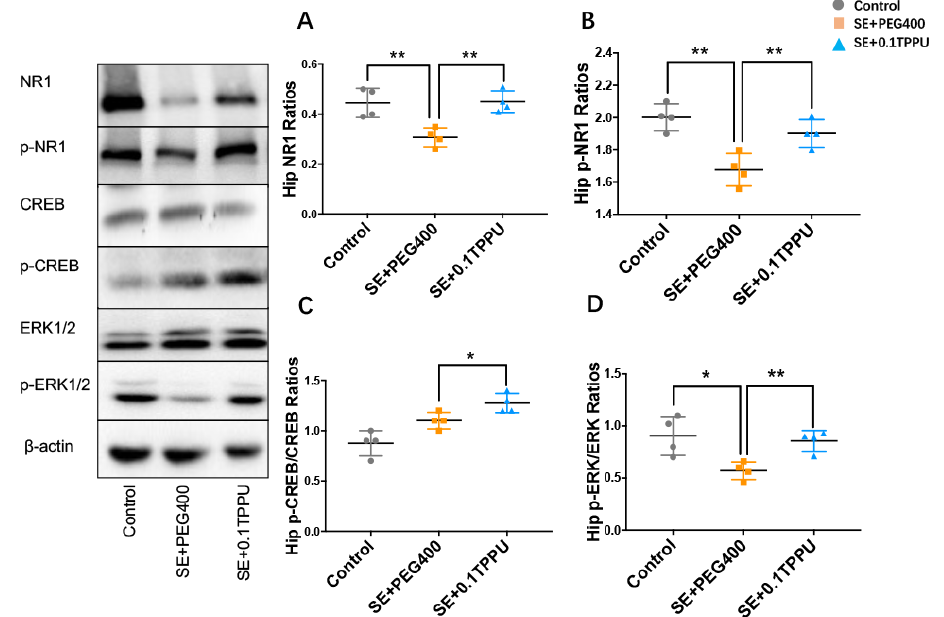
Figure 8. ( A , B ) The ratios of NR1 and p-NR1 subunits of NMDA receptor was significantly de- creased in the hippocampus of the SE+PEG400 group compared with the Control group, which was significantly increased in the SE+0.1TPPU group compared with the SE+PEG400 group after TPPU treatment. ( C , D ) The ratios of p-ERK1/2/ERK1/2 and p-CREB/CREB in the hippocampus were sig- nificantly increased in the SE+0.1TPPU group compared with the SE+PEG400 group. (Figure 8A–D, one-way ANOVA test, n = 4 in every group, * p < 0.05 ** p < 0.01). The figure on the left showed the bands of NR1, p-NR1, CREB, p-CREB, ERK1/2, p-ERK1/2, and β -actin in the Control, SE+PEG400, and the SE+0.1TPPU groups measured by the western-blot method.Hip, hippocampus; NR1, N- methy1-D-aspartate 1 receptor; p-NR1, phospho(S889)-N-methy1-D-aspartate 1 receptor; CREB, cy- clic adenosine monophosphate-response element binding protein; p-CREB, phosphor (Ser133)-cy- clic adenosine monophosphate-response element binding protein; ERK1/2, extracellular regulated kinase; p-ERK1/2, phospho (Thr202/Tyr204)-p44/42 extracellular regulated